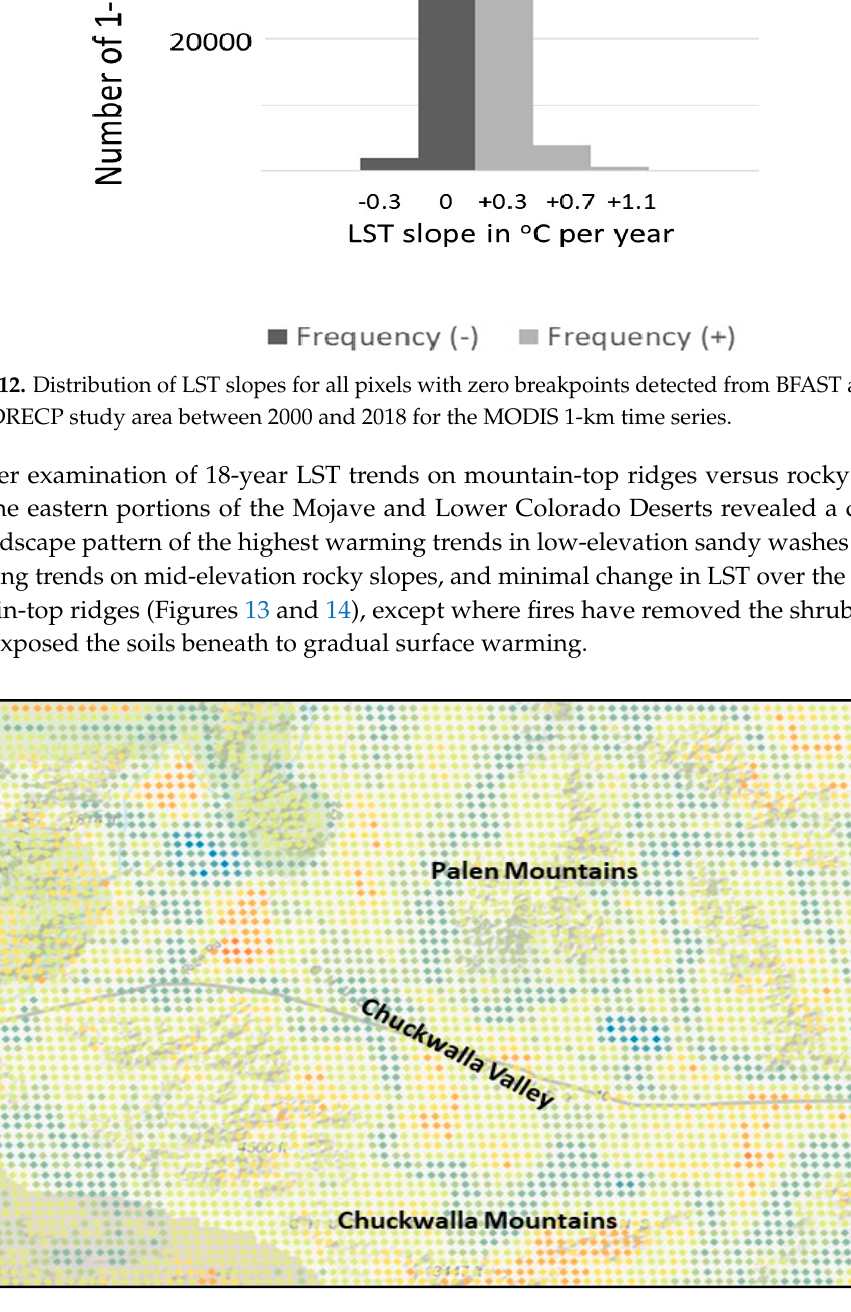
Figure 13. LST slope results for the Chuckwalla Valley and Palen-McCoy Wilderness in Riverside County, CA, with positive (warming) BFAST LST slope values in orange-red shades and negative (cooling) LST slope values in blue shades; areas of no change in LST are shaded in yellow. The map is upward in the northern direction.